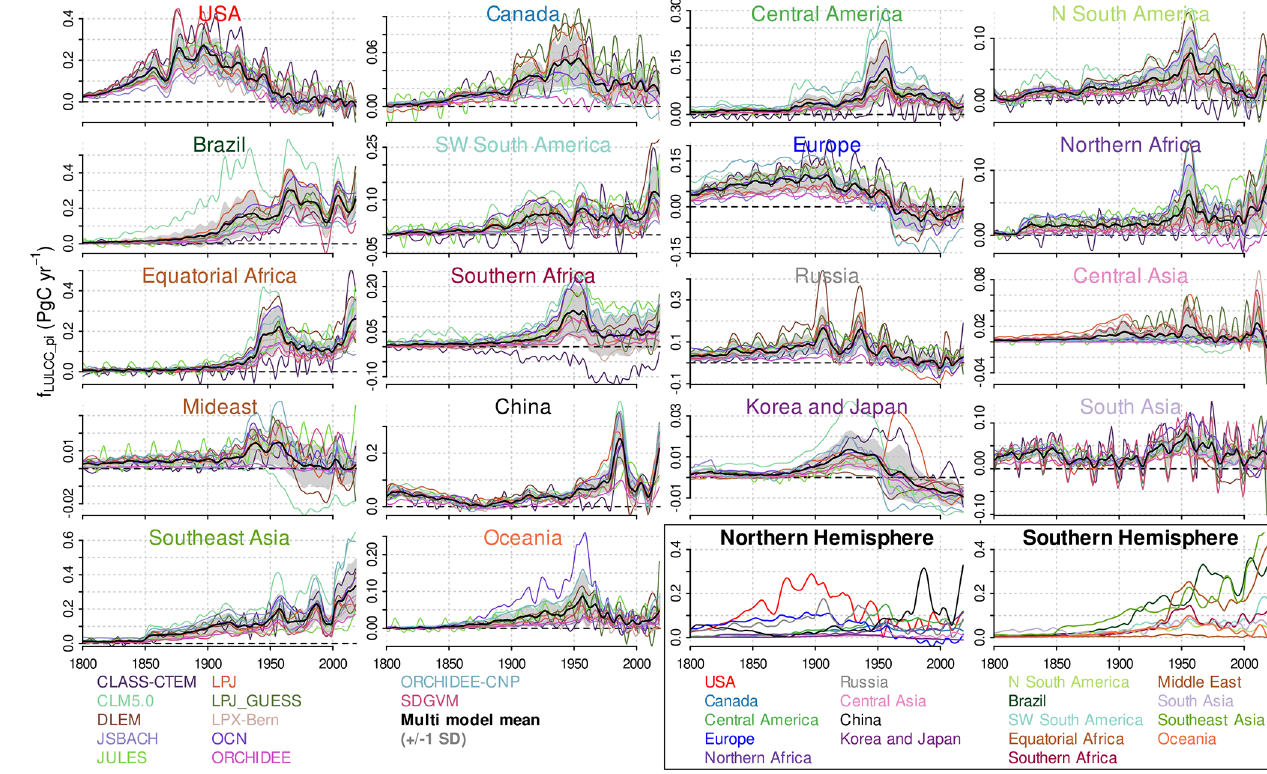
Figure A8. Region-wise smoothed annual f LULCC_pi for different models from 1800 onward (compare Eq. 2). For a discussion of individual models refer to Sect. A1. The last two panels show regional ensemble means on a uniform